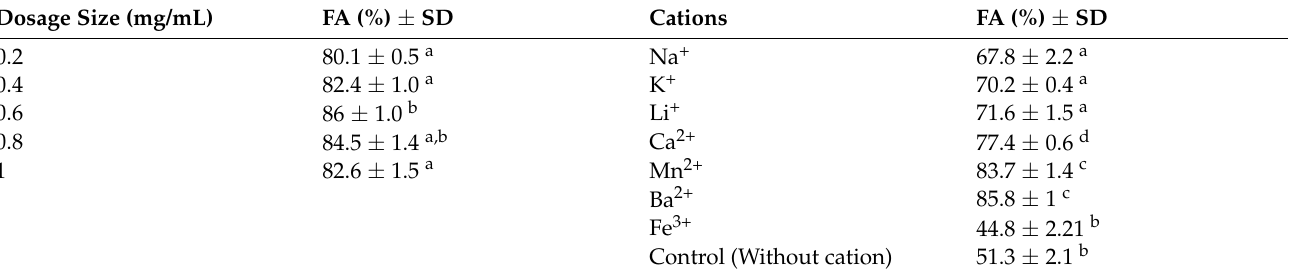
Table 3. Effect of dosage size and cations on flocculating activity.